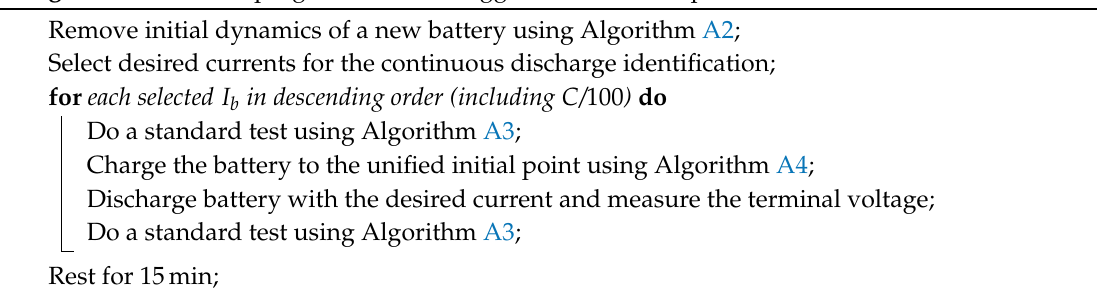
Algorithm A1: Main program with the suggested order of experiments.